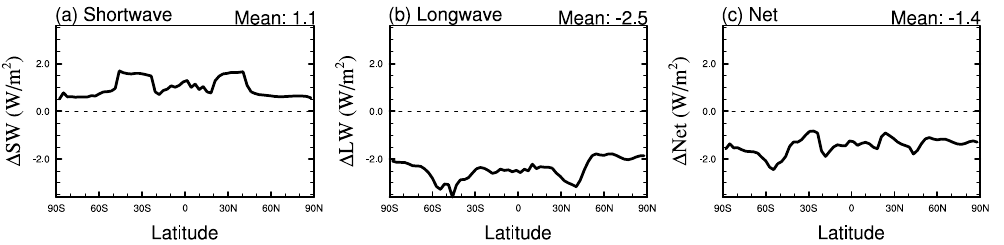
Fig. 5. Changes of surface-absorbed shortwave radiation fluxes (a) , downward longwave radiation fluxes (b) and net fluxes ( c , i.e. shortwave pluses longwave) for the case of 50% ozone, relative to the control experiment with unperturbed ozone. All of the values are for annual- and zonal-mean under clear-sky conditions. The CO 2 level is 100ppmv. Positive/negative values indicate warming/cooling effect. Global-mean value is shown at the right top of each panel. In the calculations, the influences of snow-albedo feedback (Fig. 6 below) are excluded.